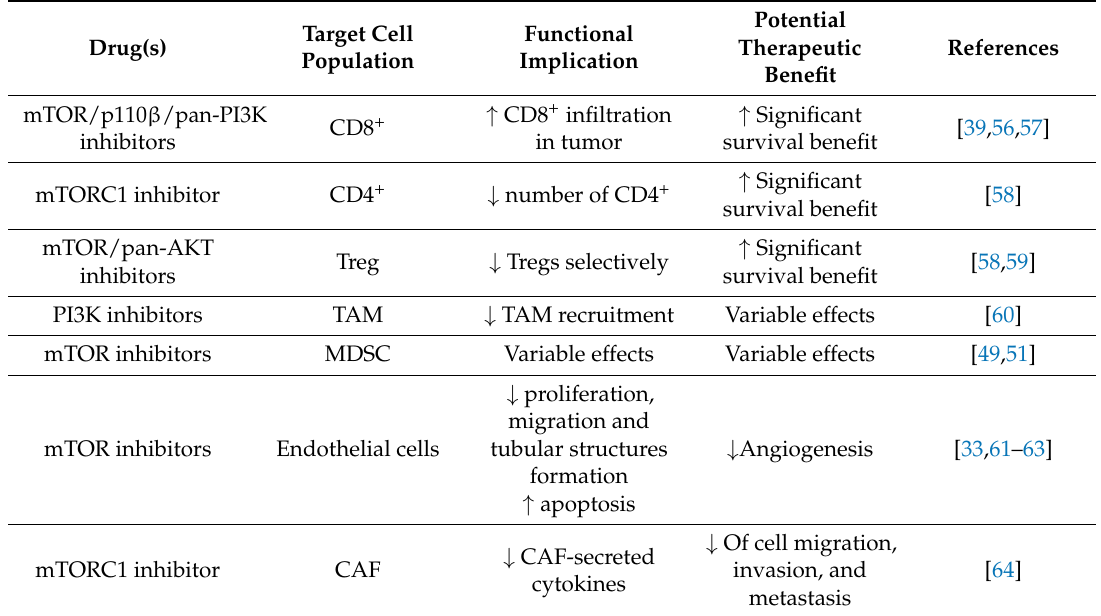
Table 2. mTOR-axis inhibitors and potential therapeutic benefit. PI3K—phosphoinositide 3-kinase; Treg—regulatory T